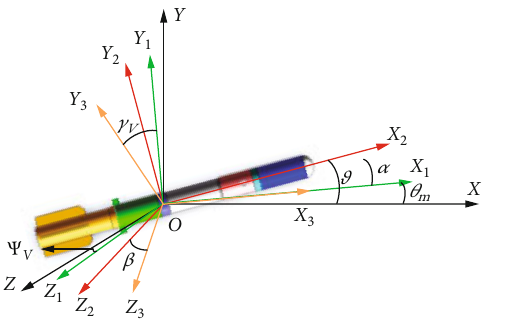
Figure 2: Coordinate and attitude of a miniature LBRS munition.